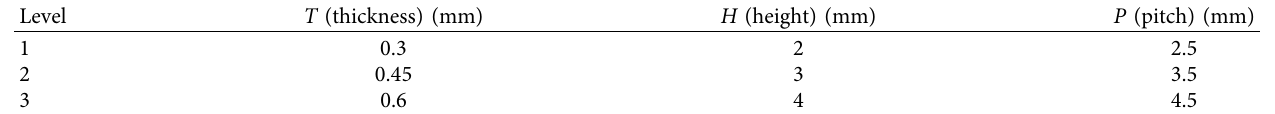
Table 4: Influencing factors and levels of gasket contact stress.